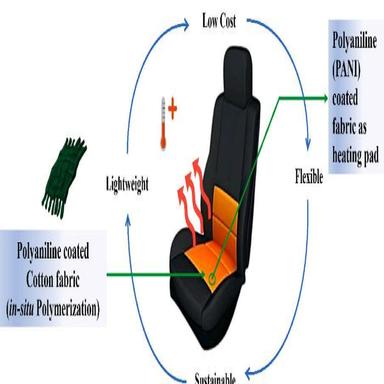
Prospect of using Polyaniline (PANI) induced fabric as a heating interface for car seat.